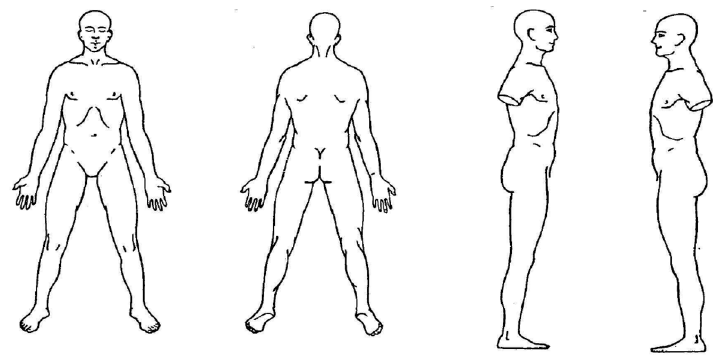
Figure 2. Mannequin sketch to mark any areas of discomfort.